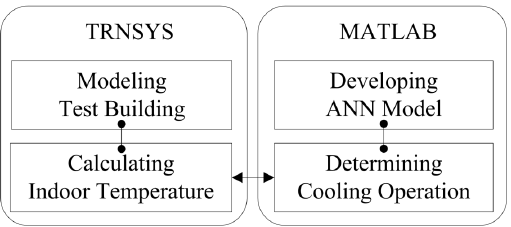
Figure 6. Incorporative process of TRNSYS and MATLAB.